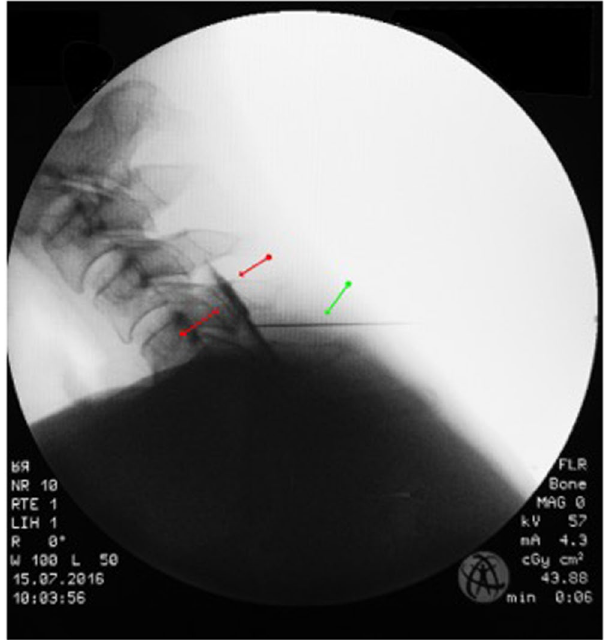
Figure 2. Typical pattern of epidural contrast agent distribution between red arrows; green arrow: needle.